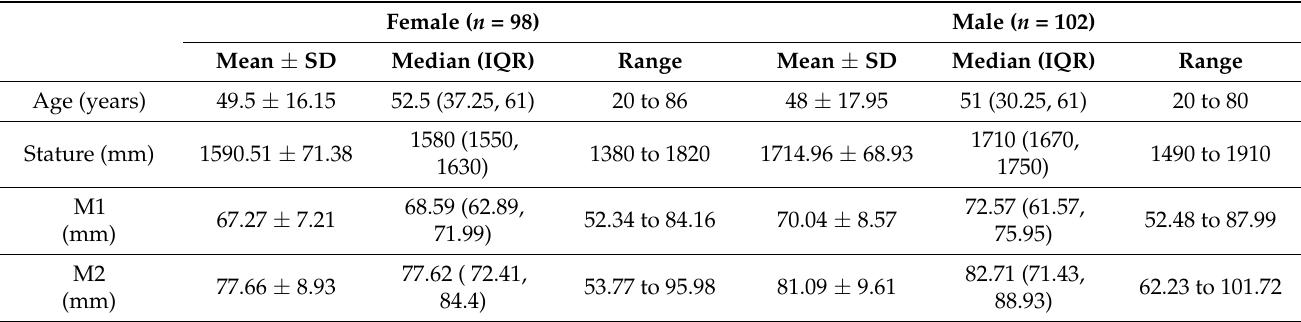
Table 2. Summary statistics (mean, standard deviation, median, and range) of age, stature, M1 (first metatarsal maximum length), and M2 (second metatarsal maximum length) measurements (mm) of both